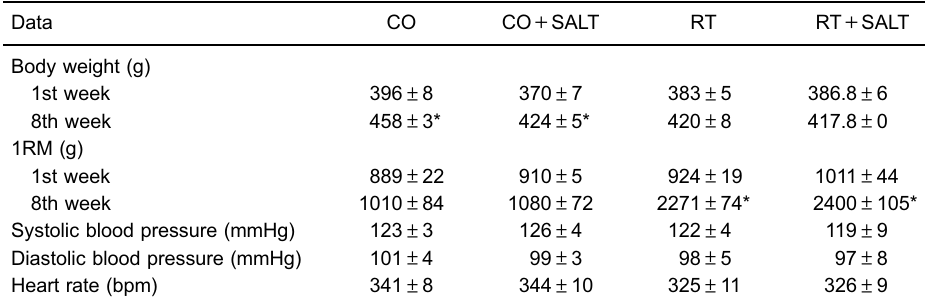
Table 1. Body mass, absolute 1RM, systolic and diastolic blood pressure, and heart